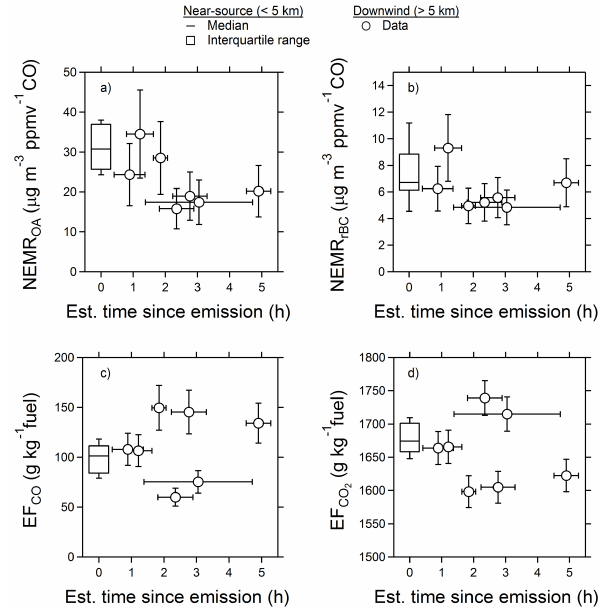
Figure 3. As in Fig. 2, but for the Francis Marion prescribed